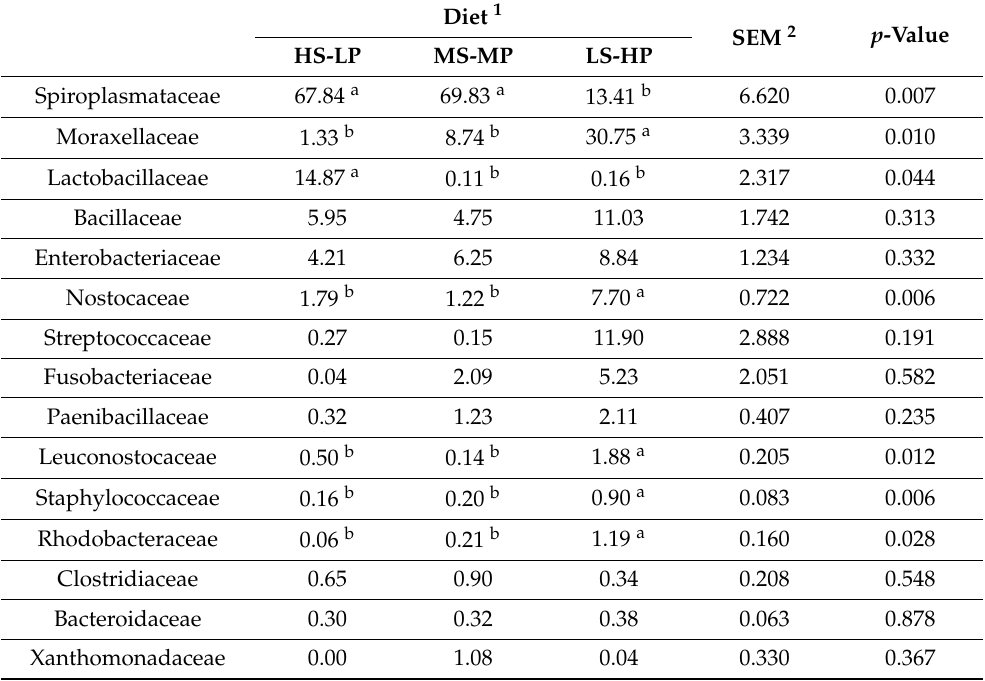
Table 9. Effect of diets on the abundance (%) of the 15 most frequent families in the microbiota of Tenebrio molitor